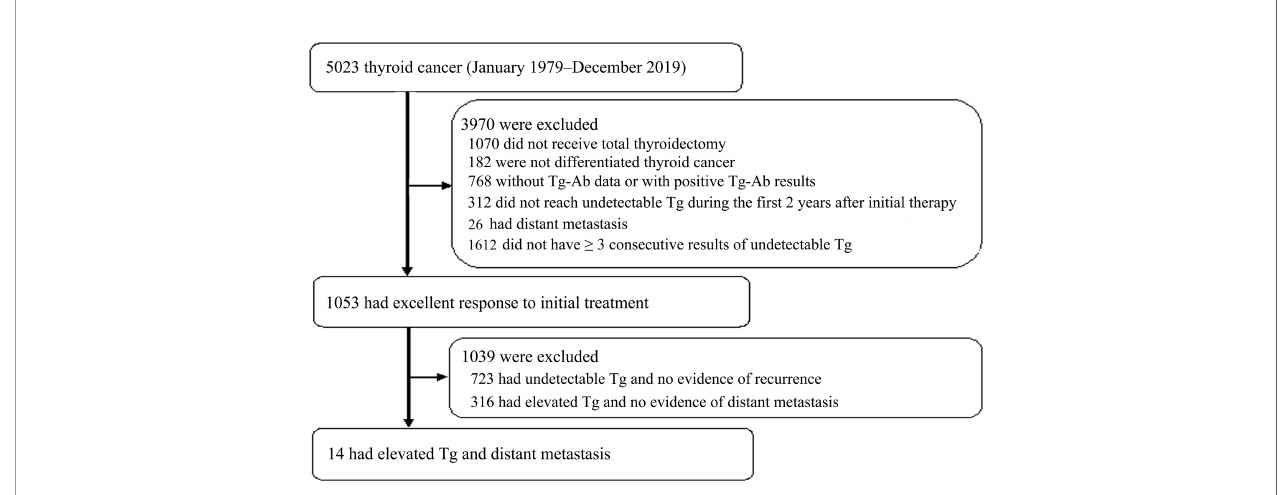
FIGURE 1 | Flowchart of cohort